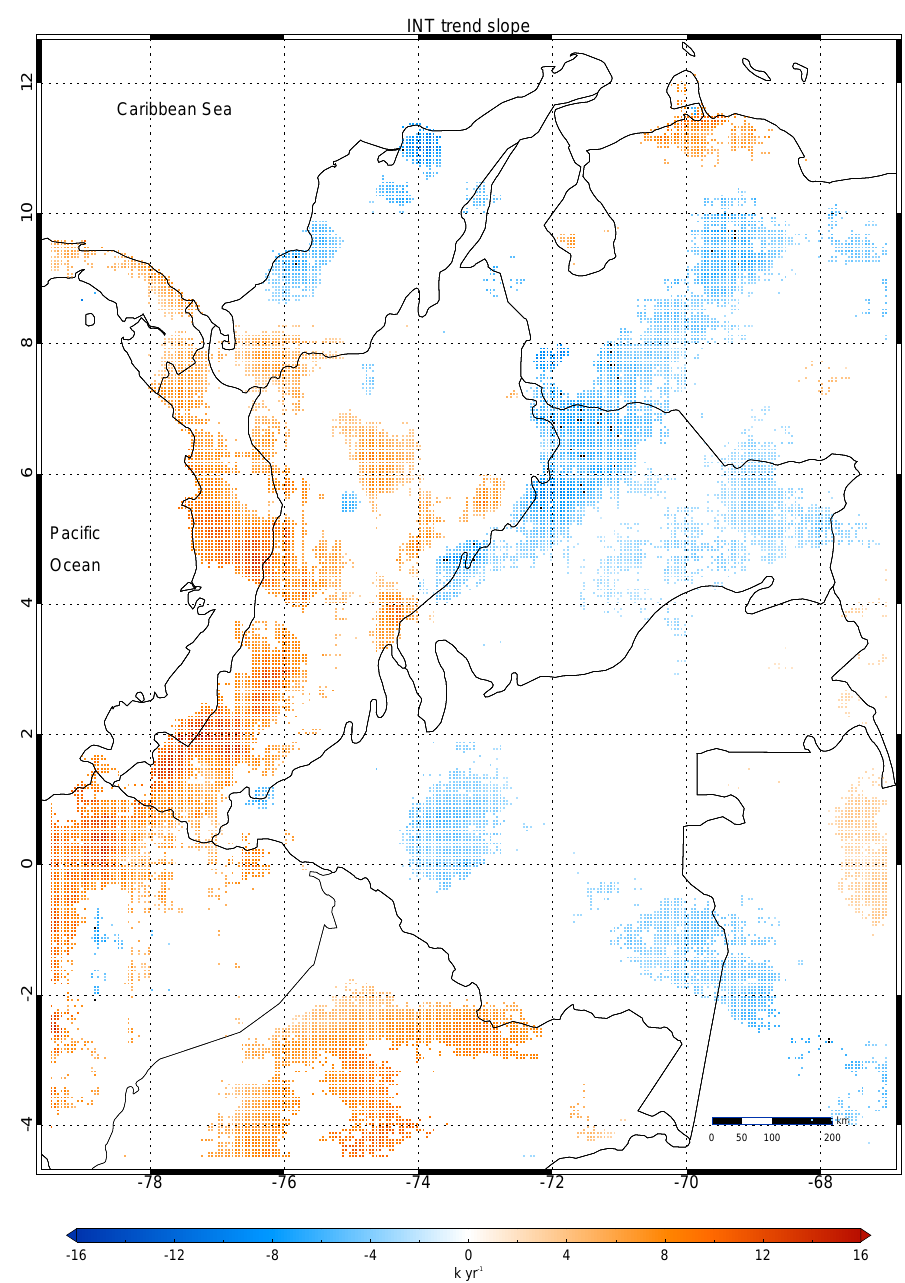
Figure 5. Map of the trend slope for INT for CHIRPS dataset. Non-significant trends are not plotted. Color scale in kyr − 1